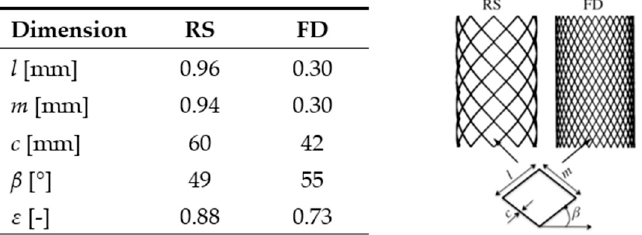
Figure 2. Geometrical configuration [31] of the RS and the FD.